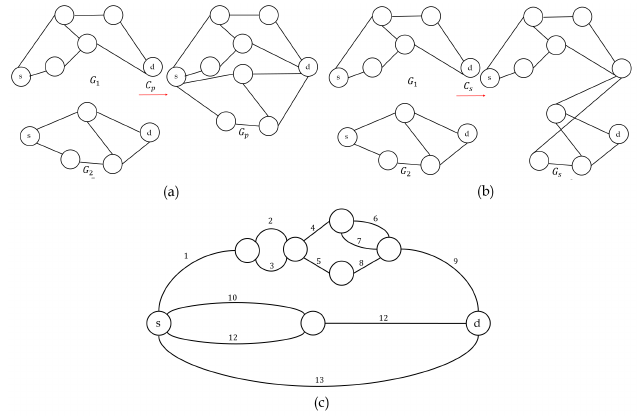
Figure 1. ( a ) The operation composition in parallel denoted by C p . ( b ) The operation composi- tion in series denoted by C s . ( c ) a sample SP graph that is represented as three parallel paths: P 1 (cid:107) P 2 (cid:107) P 3,where P 1: [ 1,2 (cid:107) 3, [[ 4,5 (cid:107) 6 ] (cid:107) [ 7,8 ]] ,9 ] . P 2: [ 10 (cid:107) 11,12 ] . P 3: [ 13 ]